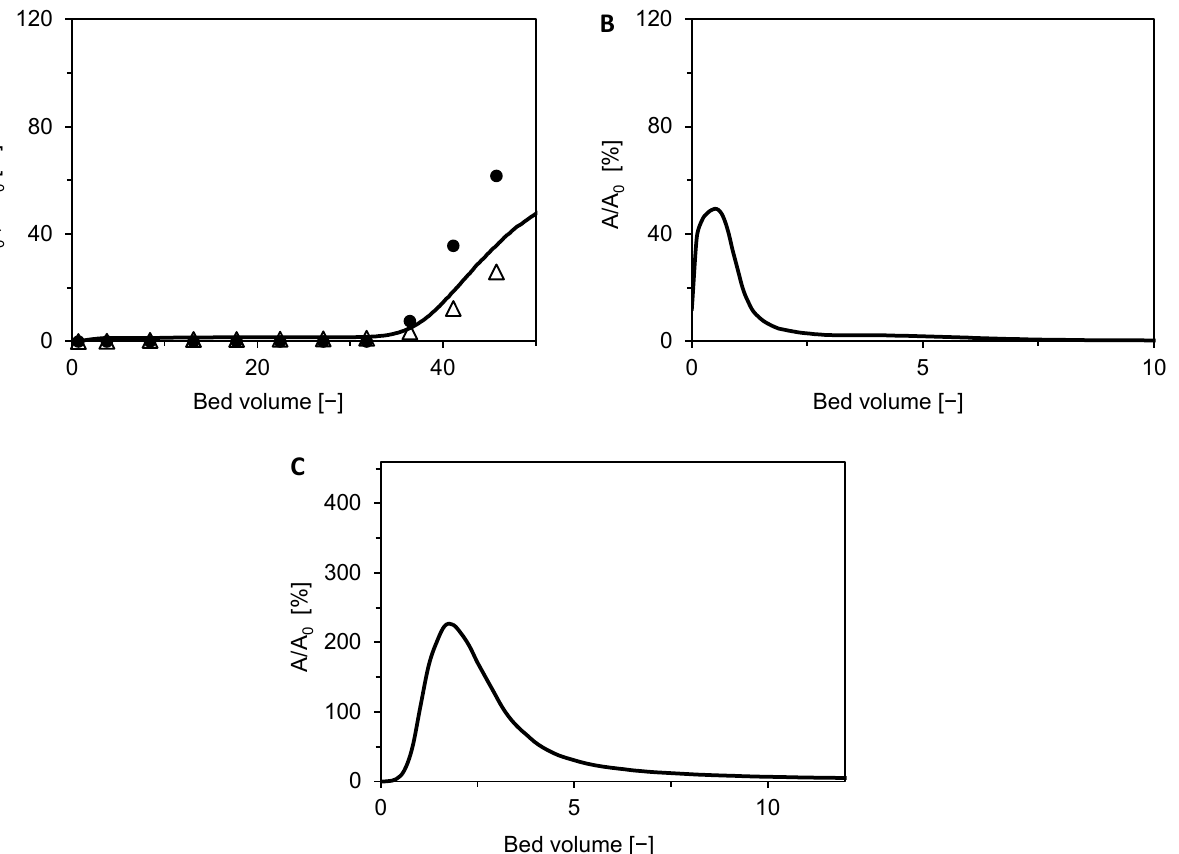
Figure 13. Two-component adsorption of BSA ( ● ) and DNA ( △ ) on Sartobind STIC using the laboratory membrane module in bind-elute mode with a loading of 48 BV. ( A ) Adsorption phase using salt-free feed. ( B ) Washing phase. ( C ) Elution phase using 0.15 mol/L Na 2 SO 4 as eluent. Symbols represent the relative concentrations of BSA and DNA in the collected fractions. The solid black line is the relative outlet stream absorbance, which is a superposition of BSA and DNA outlet concentrations. Due to the negligible content of DNA in the outlet stream of the washing and elution phases, respectively, the chromatograms in Figure 13B,C essentially represent BSA content in the outlet stream.